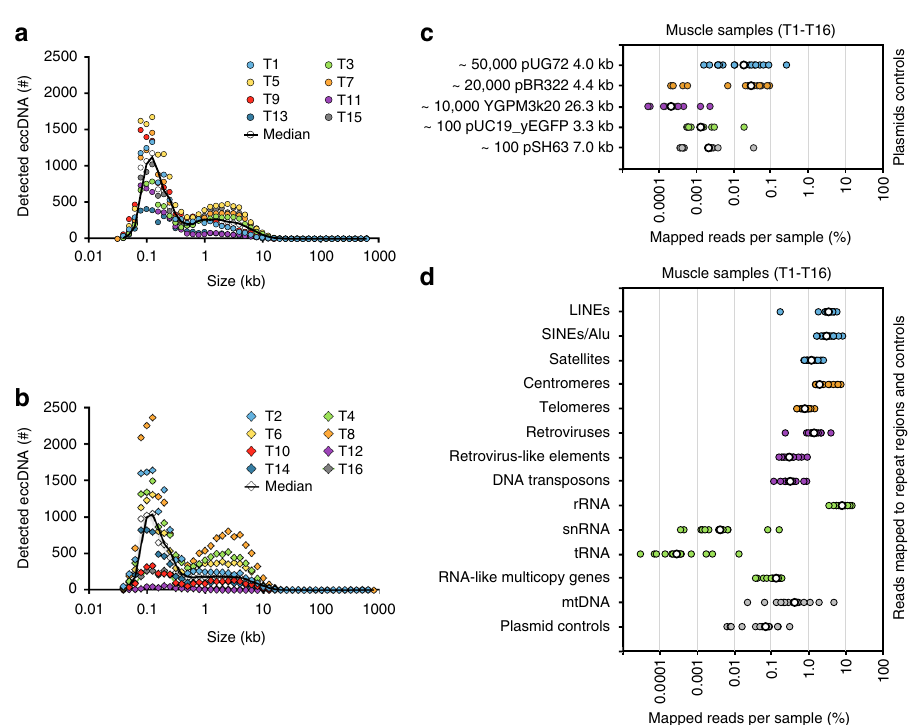
Fig. 2 EccDNA sizes, read distribution on plasmids and repetitive elements. Number of eccDNAs relative to size in kb for 1 × 10 6 muscle nuclei from each individual. a Physically inactive men ( n = 8); b active men ( n = 8). EccDNA kb sizes are in bins of 0.1 log-fold intervals. c Percent mapped reads per sample for plasmids added to muscle samples at indicated copy numbers (median, white circles). d Repetitive regions from total mapped reads for each muscle- derived eccDNA sample (T1 – T16); median, white circles ( n =